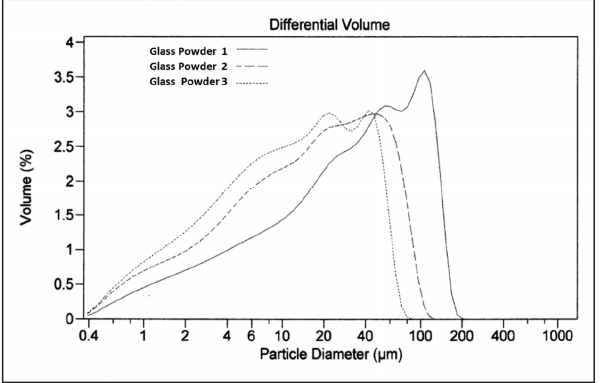
Figure 3. Distribution of the accumulated granulometry of the three batches of glass powder.